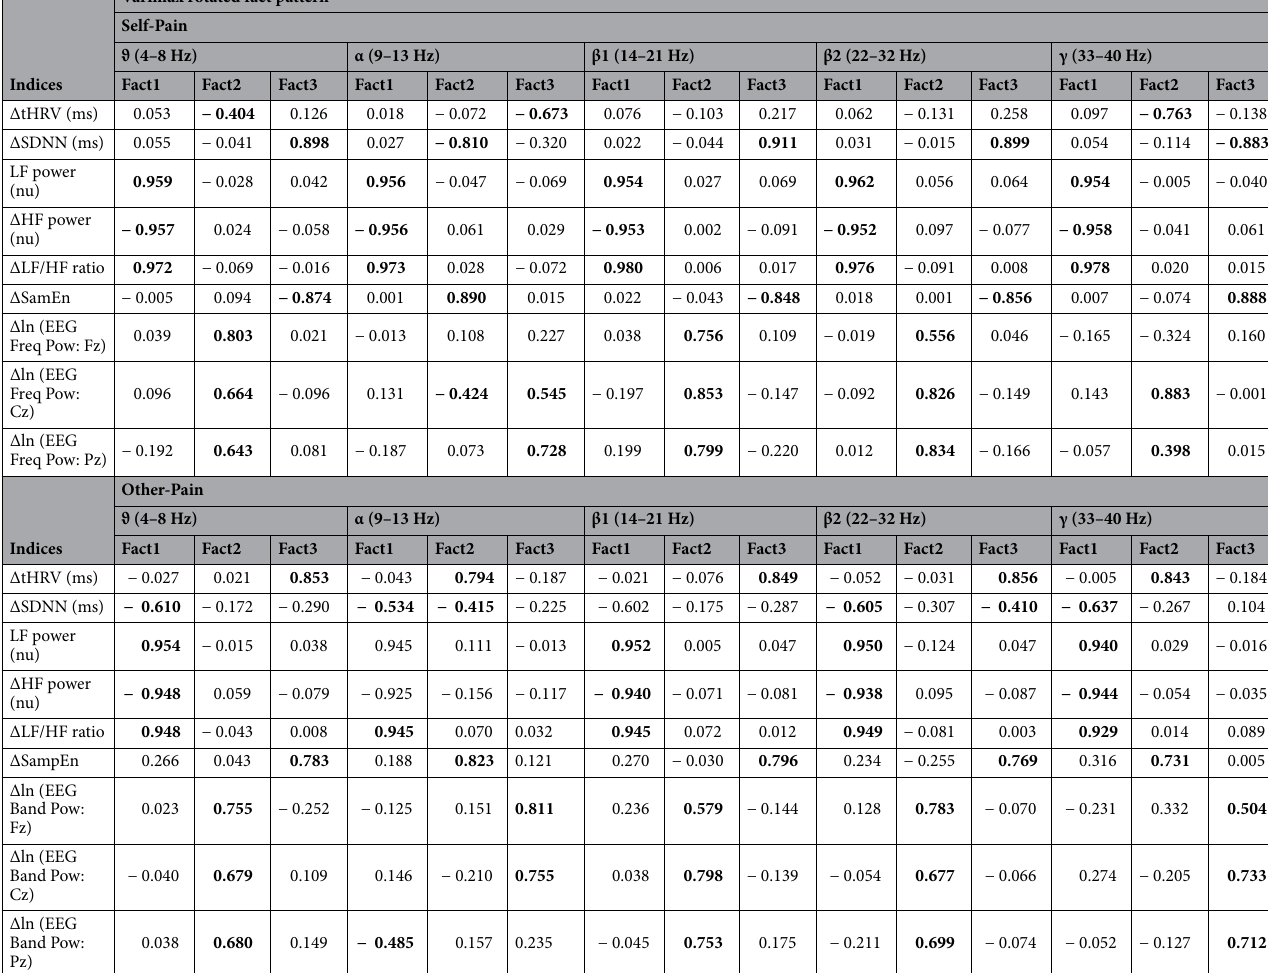
Table 1. Principal Component Analysis (PCA) factors as obtained using Pain minus Placebo differences scores of HRV and EEG frequency band power scores (N = 62). Significant values are in bold. We got three factors solution (Fact1, Fact2, and Fact3) by separate PCA analyses including HRV indices and, singly, each EEG band power of ϑ, α, β1, β2, and γ rhythms, performed respectively for Self- and Other-Pain conditions. Pain minus Placebo difference scores (∆) for the indices of R–R: mean of R–R intervals; SDNN: standard deviation of R–R intervals; LF: low frequency; HF: high frequency; SampEn: sample entropy; ln (EEG Band Pow): natural logarithm transform of each EEG band power of interest (ϑ, α, β1, β2, and γ) at Fz, Cz, and Pz recording